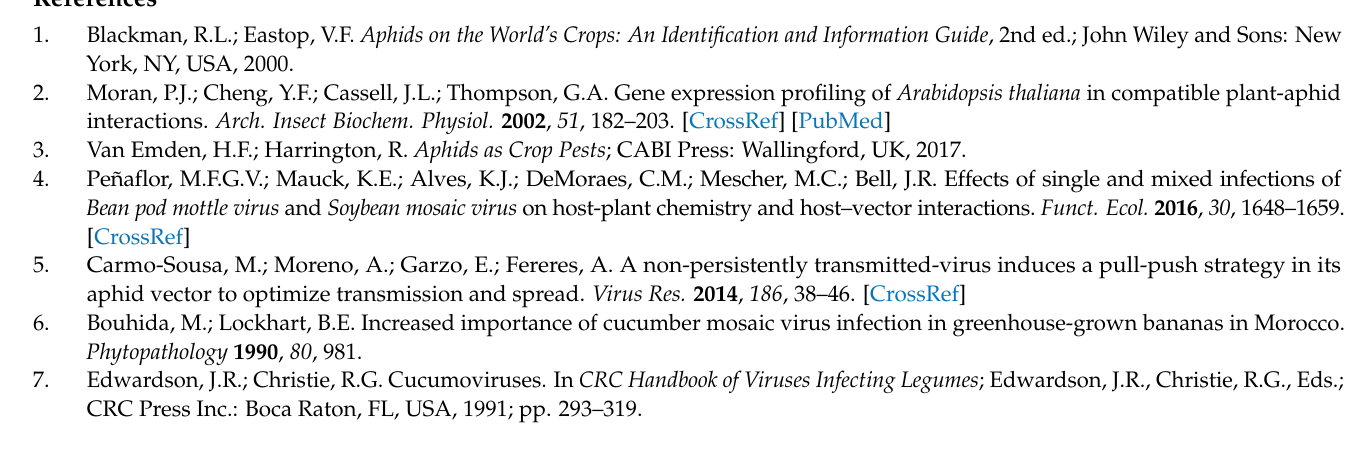
Table S4. GO-enriched for transcriptome dataset, Table S5. KEGG pathway for transcriptome dataset, Table S6. qRT-PCR verified differentially expressed genes, Table S7. Identification of differentially- accumulated proteins in Unitprot database, Table S8. Integrated function annotation for proteomic dataset, Table S9. Significant changes in both the transcript and the protein